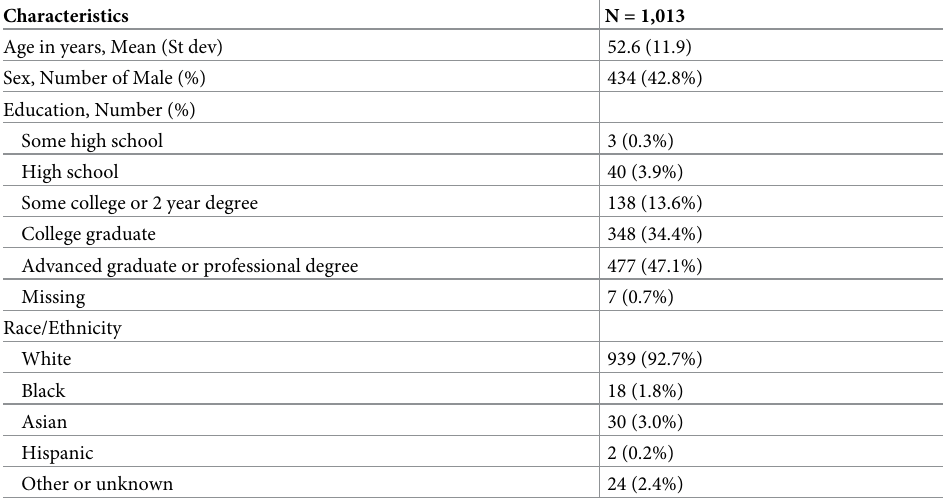
Table 1. Demographics of 1,013 patients who provided informed consent and completed the autoimmune disease questionnaire.